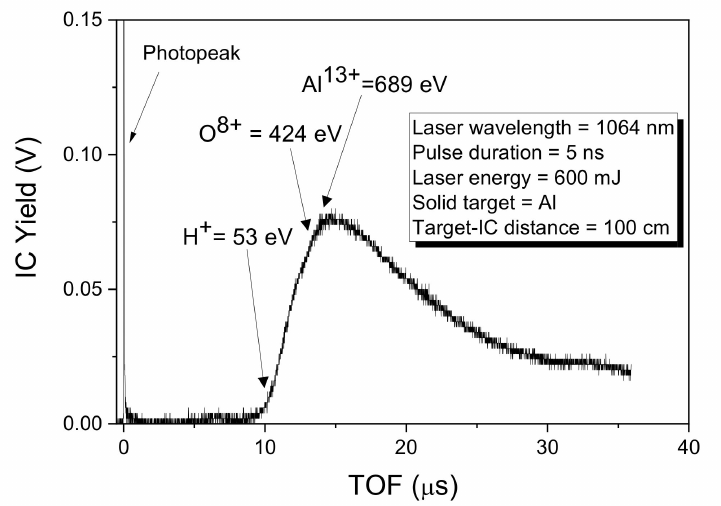
Figure 4. Spectrum in TOF obtained from a Faraday Cup for a target of Al irradiated by laser. The intense photopeak is followed by a large, structured peak extending from 9